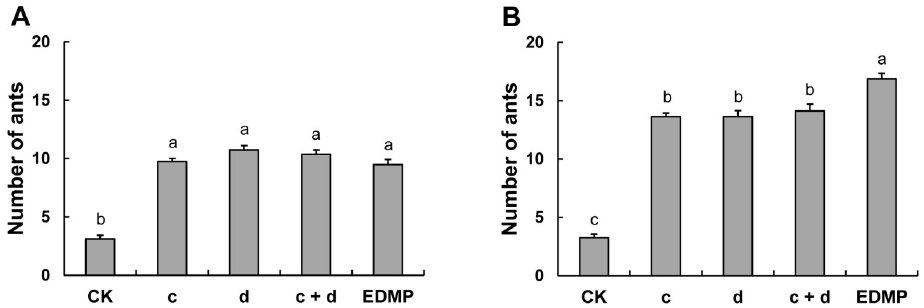
Figure 6. Alarm response of S. invicta workers to HPLC-purified EMPc, EMPd, and their mixture. ( A ) Dose = 10 ng; ( B ) Dose = 100 ng. c = EMPc, d = EMPd. Means for the same dose having no letter in common on each bar of the histogram (a, b, and c) are significantly different ( P < 0.05, Tukey-HSD test).